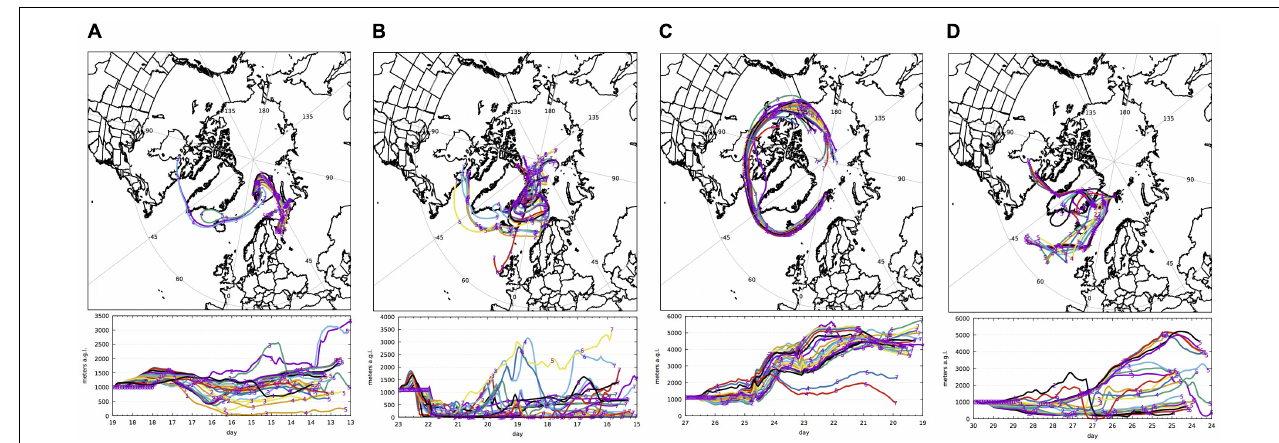
FIGURE 3 | Plots of 120 h back trajectories of April 18 (A) , 22 (B) , 26 (C) , and 29 (D) , 2011 ending at 1000 m a.g.l. (April 18 and 29) and at 1100 m a.g.l. (April 22 and 26) upon Ny-Ålesund.